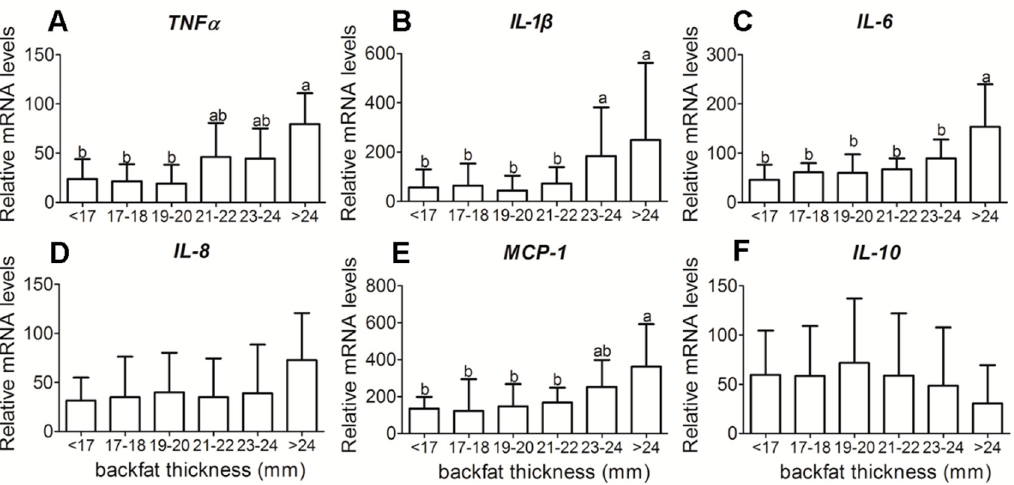
Figure 3. Pro-inflammatory cytokines and anti-inflammatory cytokines mRNA expressions in placenta tissue of different backfat thickness sows. ( A ) Placental reactive tumor necrosis factor α ( TNF α ) mRNA level; ( B ) Placental reactive interleukin (IL)- 1 β mRNA level; ( C ) Placental reactive IL - 6 mRNA level; ( D ) Placental reactive IL-8 mRNA level; ( E ) Placental reactive monocyte chemoattractant protein-1 (MCP-1)mRNA level; ( F ) Placental reactive IL-10 mRNA level mRNA level;. Each group had 10–12 sows, 4–5 placenta samples were analyzed per sow, mean ± SEM. Different letter showed significant difference ( p < 0.05).